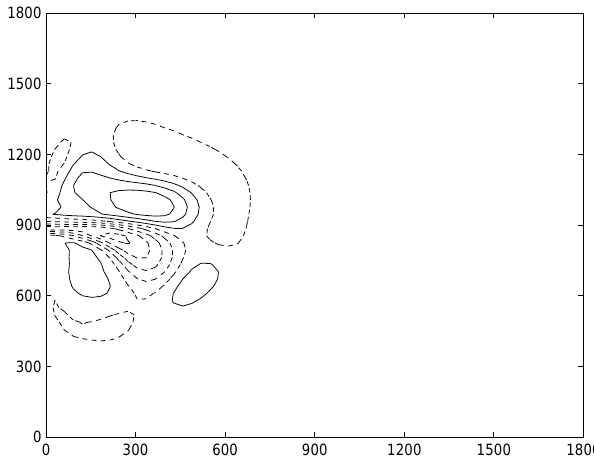
Fig. 14: Difference between the SST field of an asymmetric state for which ∆ E oc > 0 and that of Fig. 14. Difference between the SST field of an asymmetric state the antisymmetric state, both obtained for σ =0 . 9 . Contours every 2 K; to be compared with Fig. 4. for which 1E oc > 0 and that of the antisymmetric state, both ob- tained for σ = 0 . 9. Contours every 2K; to be compared with Fig. sphericandoceaniccirculation. Westudiedseparatelytheeffectsoftheatmosphereontheocean,as well as those of the ocean on the atmosphere. Doing so allowed us to focus on the atmosphere’s in- 450 trinsic low-frequency variability (LFV) when subject to forcing by the SST field. The originality of ourocean-atmospheremodelliesintheparametrizationoftheEkmanboundarylayerinthemodel’s atmospheric component, cf. Feliks et al. (2004, cited as FGS in the main text).